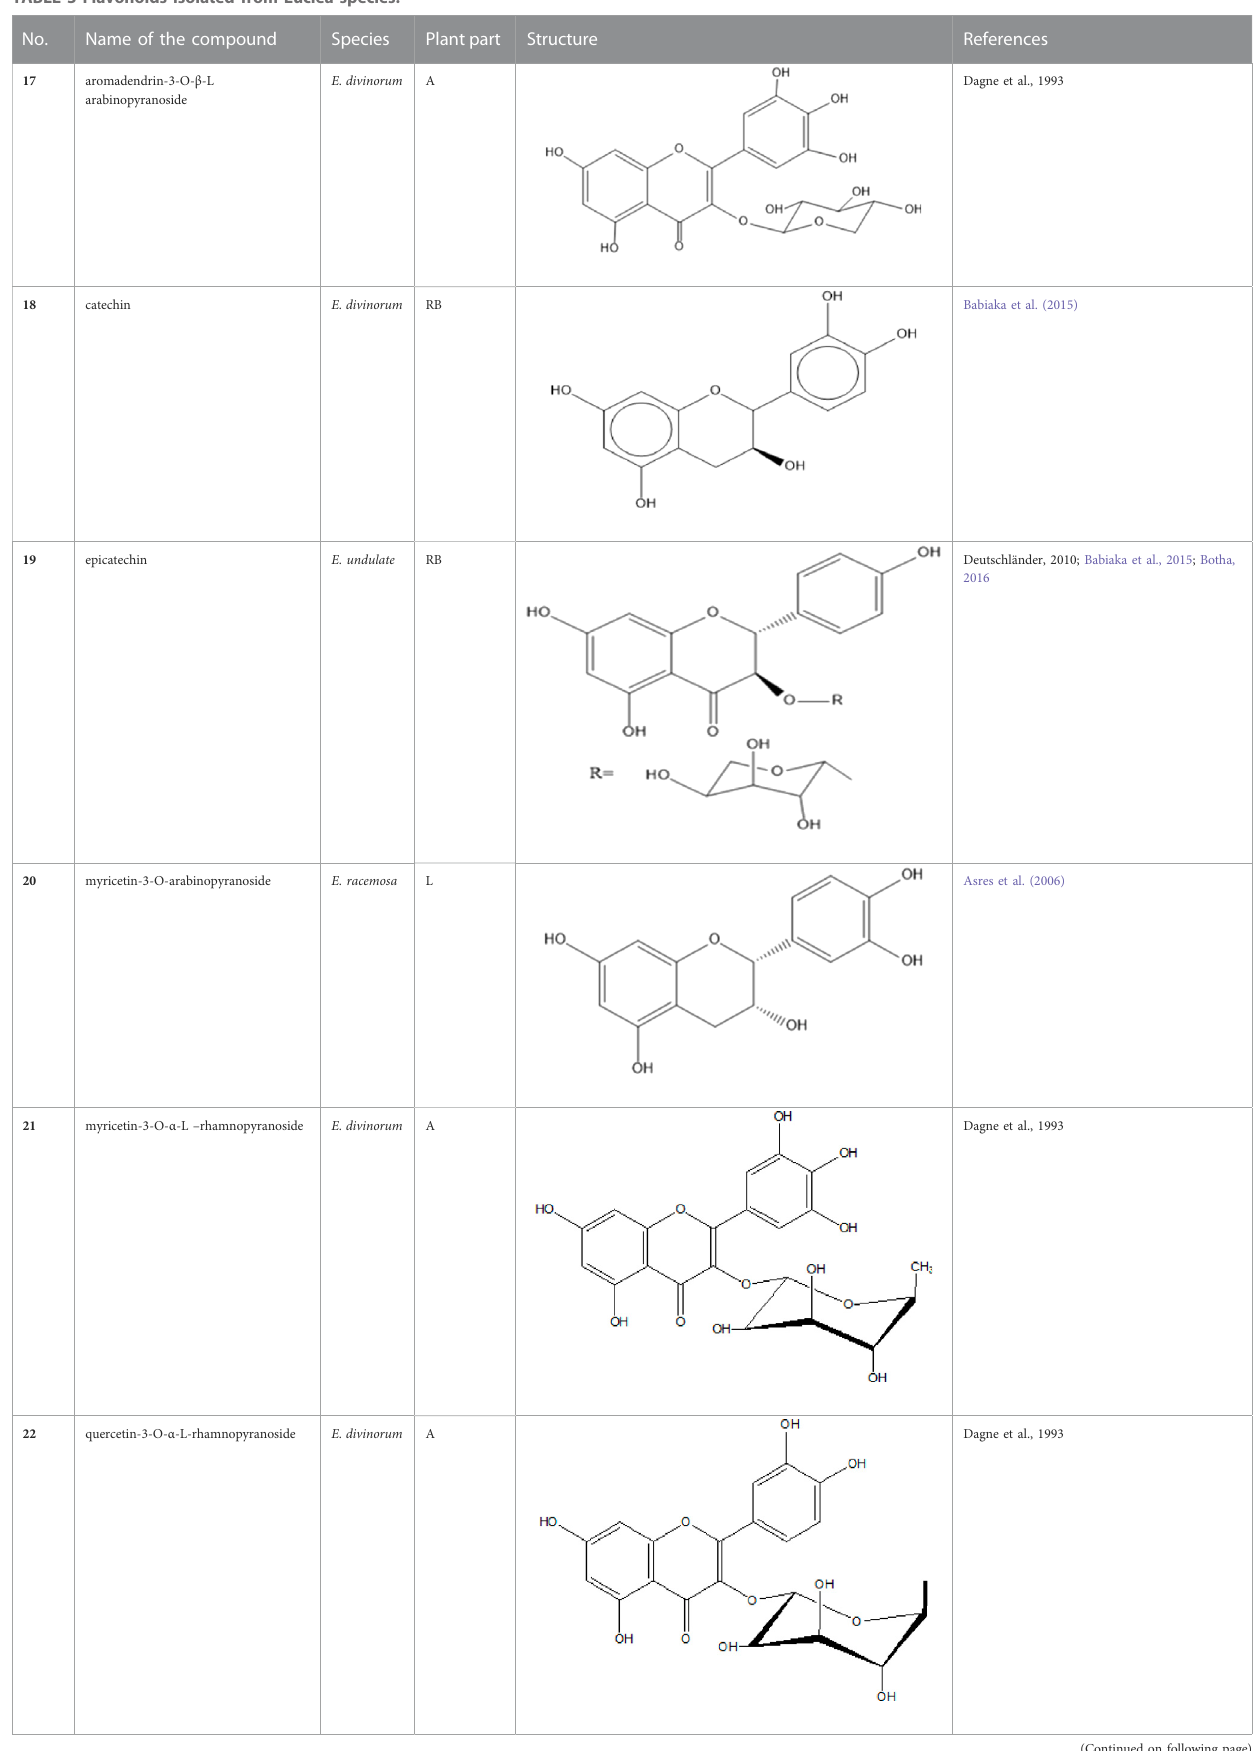
TABLE 3 Flavonoids isolated from Euclea species.